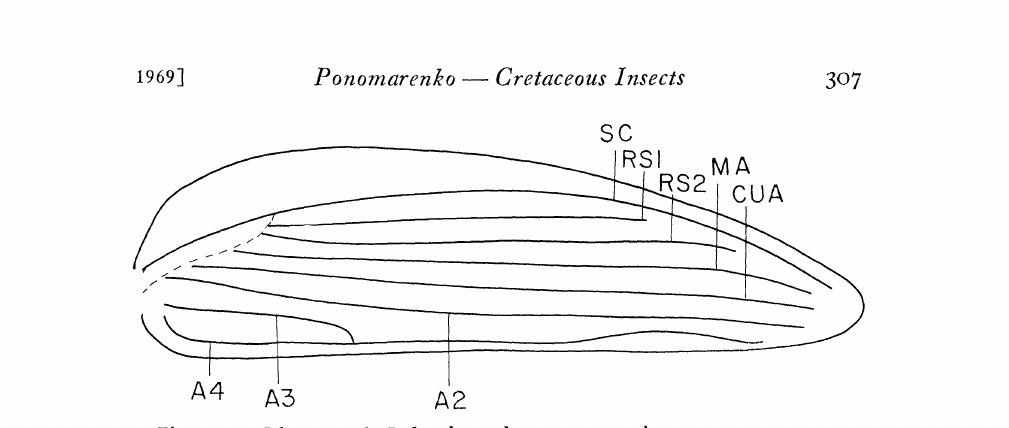
Figure 1. Elytron of Labradorocoleus carlenteri, gen. nov., sp. nov. Interpretation of venation based on